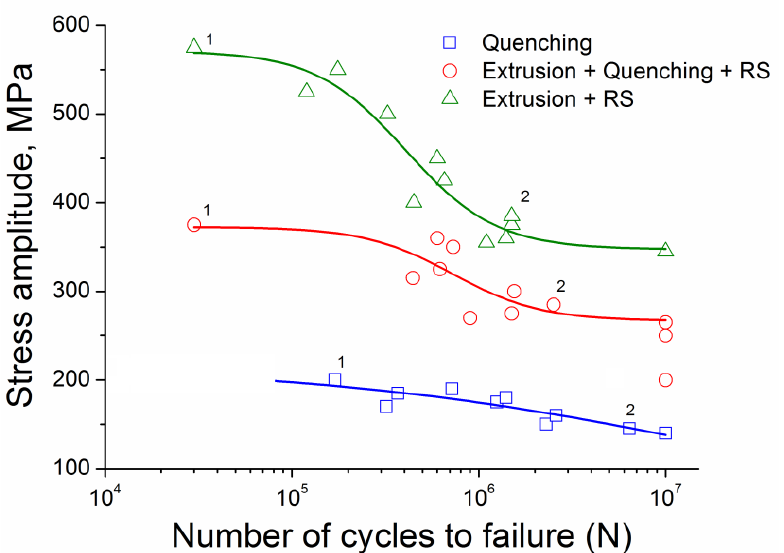
Figure 6. The Woehler (S-N) curves for cyclic deformation of Cu-0.5%Cr-0.08%Zr alloy in different microstructural states.